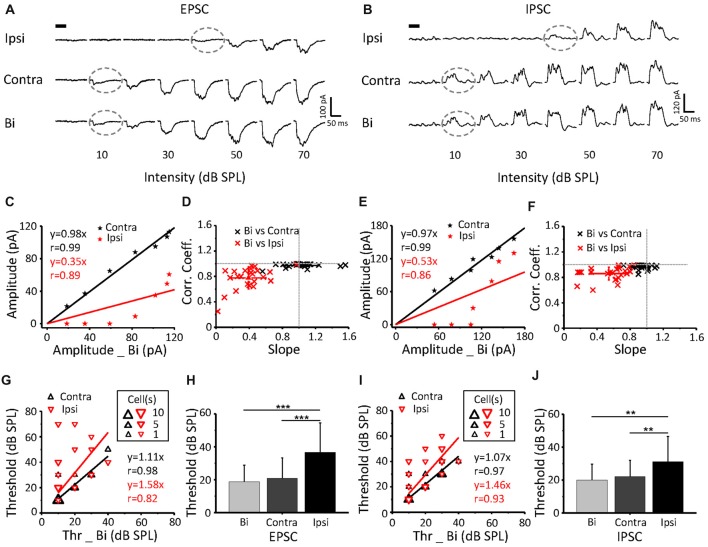
The relationship of binaural synaptic response against monaural responses when stimulus intensity was equal. (A,B) An example ICC neuron showed superimposed CF tone-evoked excitatory (A) and inhibitory (B) synaptic current responses under ipsilateral, contralateral and binaural stimulation. The black bar indicates the 50 ms long acoustic stimulus. The dashed lines indicate the threshold. (C,E) Binaural evoked excitatory (C) and inhibitory (E) synaptic responses vs. the corresponding contralateral (the black line) or ipsilateral (the red line) evoked response to the same tone plotted for the cell shown in (A,B). (D,F) Distribution of the correlation coefficient vs. slope in the recorded population (excitatory (E)
n = 23; inhibitory (F)
n = 25). (G,I) Binaural synaptic response thresholds vs. the corresponding contralateral and ipsilateral thresholds. (H,J) Comparison of the thresholds of EPSCs (H) and IPSCs (J) among ipsilateral, contralateral and binaural stimulation. Contra-EPSC, 20.9 ± 12.4 dB SPL; ipsi-EPSC, 36.5 ± 18 dB SPL; and binaural-EPSC, 18.7 ± 10.1 dB SPL; n = 23; one-way ANOVA, p < 0.001; least significant difference (LSD) tests for multiple comparisons, p = 0.598 (contra-binaural). Contra-IPSC, 22.4 ± 10.9 dB SPL; ipsi-IPSC, 31.2 ± 15.4 dB SPL; and binaural-IPSC, 20 ± 9.6 dB SPL; n = 25; one-way ANOVA, p < 0.01; LSD tests for multiple comparisons, p = 0.556 (contra-binaural). **p < 0.01; ***p < 0.001. Data are expressed as the mean ± SEM.